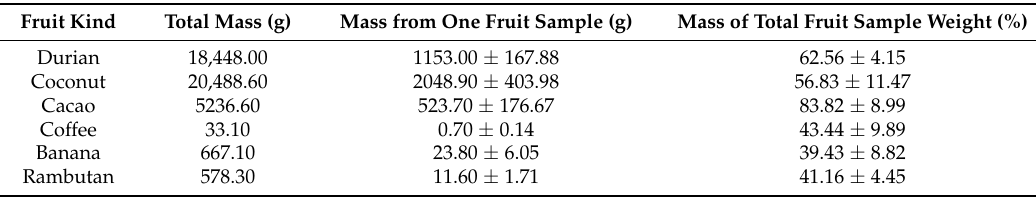
Table 2. Mass proportion of fruit waste biomass (in